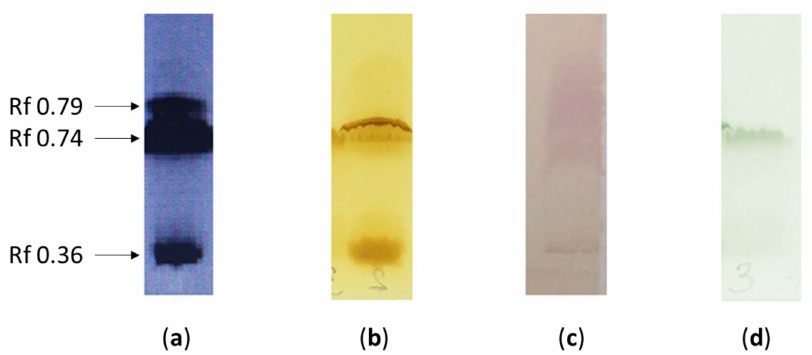
Figure 3. Characterization of the chemical structure of the biosurfactant using TLC: ( a ) spots under UV light, ( b ) spots after iodine staining, ( c ) spots after ninhydrin staining, ( d ) spots after anisalde- hyde staining.